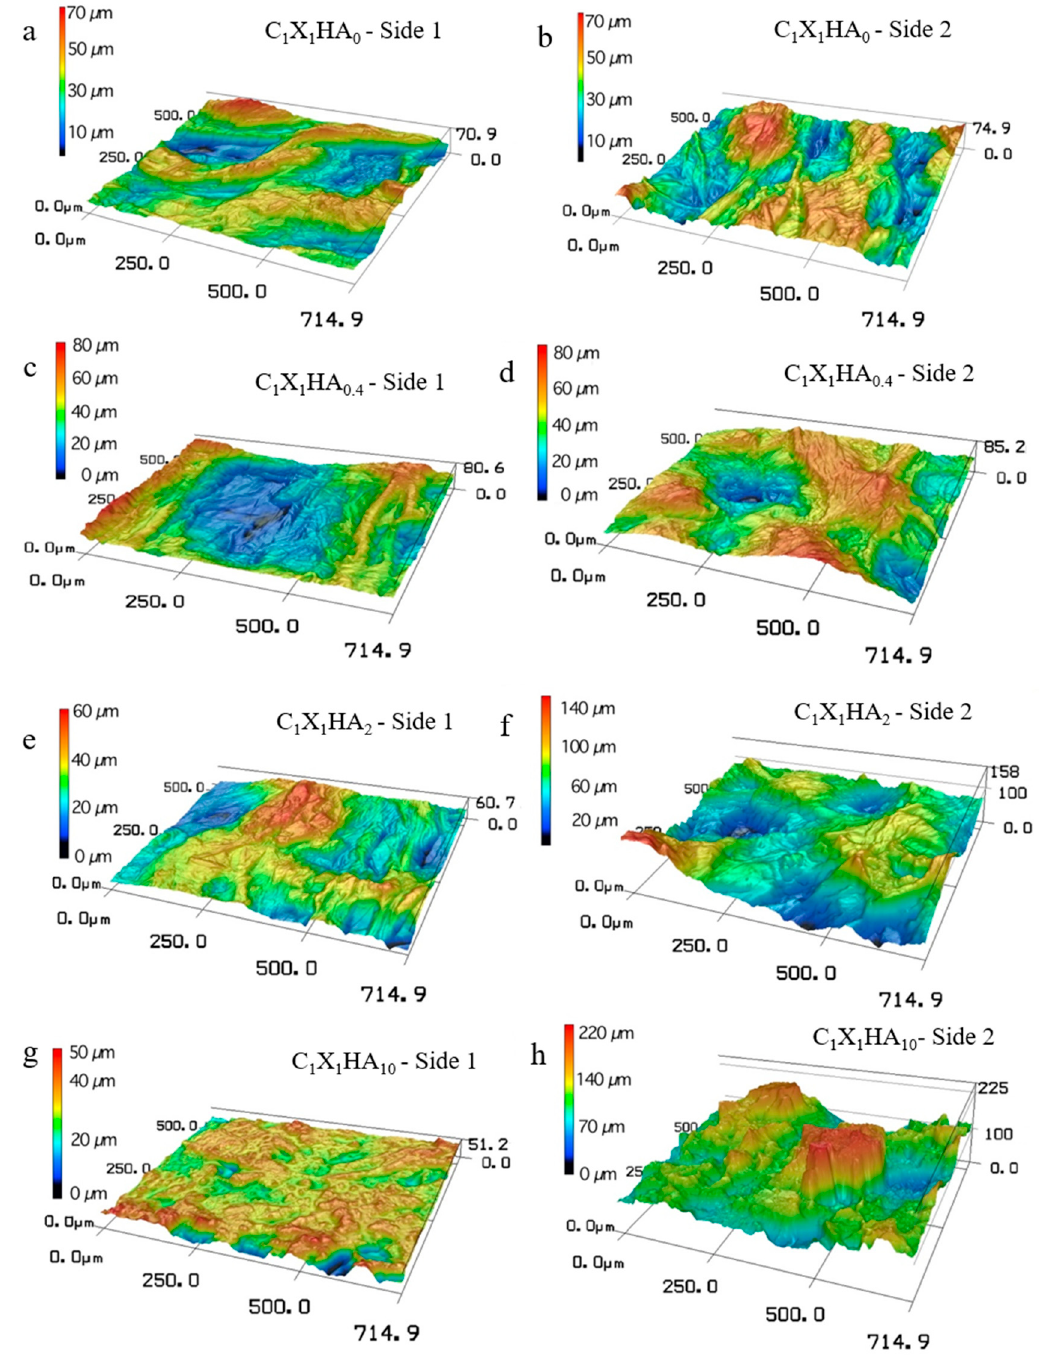
Figure 5. Three-dimensional images of membranes exposed to PBS solution at 35 °C for 1 h obtained by confocal microscopy. Side 1 corresponds to the surface that was in contact with the Petri dish during the drying step of the membrane fabrication (smoother surface), while side 2 refers to the surface exposed to the atmosphere (rough surface): ( a , b ) side 1 and 2 for C 1 X 1 HA 0 ; ( c , d ) side 1 and 2 for C 1 X 1 HA 0.4 ; ( e , f ) side 1 and 2 for C 1 X 1 HA 2 ; ( g , h ) side 1 and 2 for C 1 X 1 HA 10